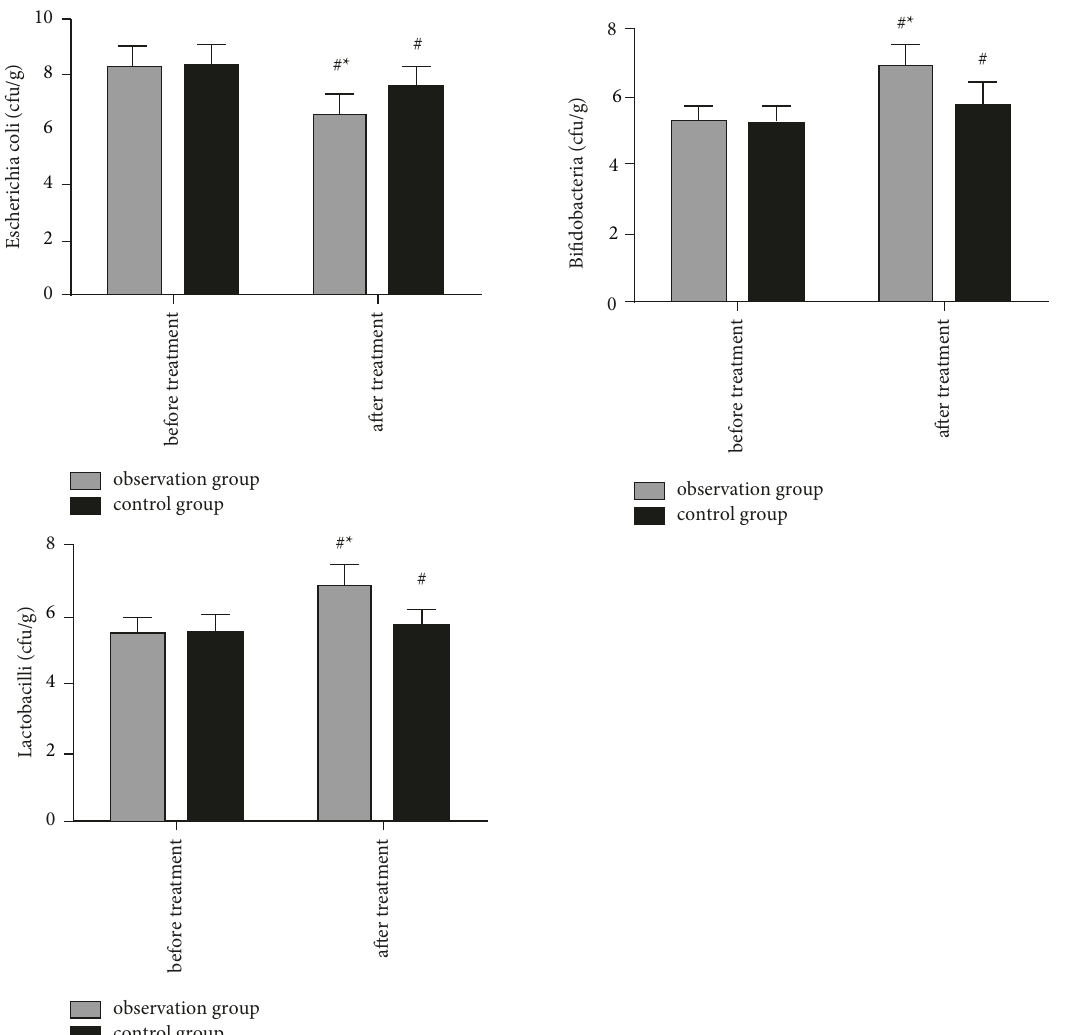
Figure 3: The differences of intestinal flora between groups with/without prebiotics/probiotics preparations ( # P < 0 . 05 represents com- paring with the same group before treatment; ∗ P < 0 . 05 represents comparing with the control